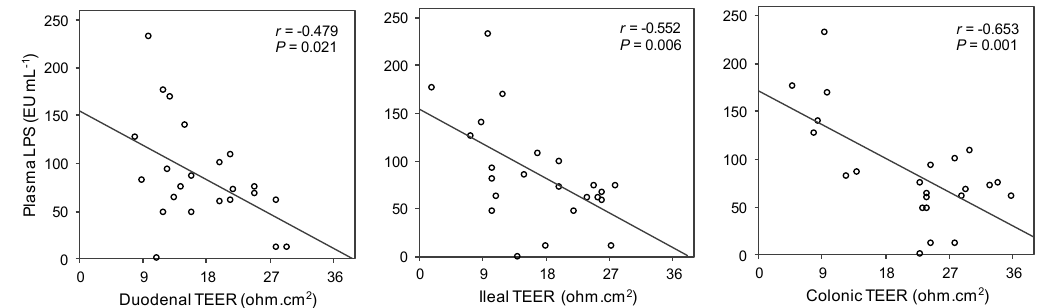
Figure 6. The linear relationship between endotoxemia and TEER values in small and large intestines of